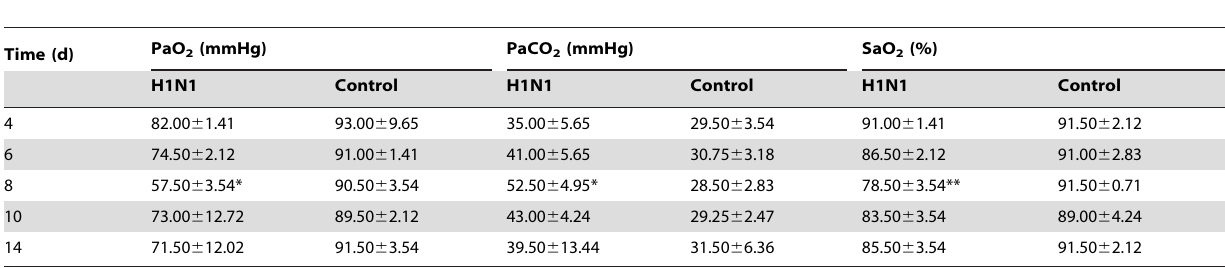
Table 1. Arterial blood gas